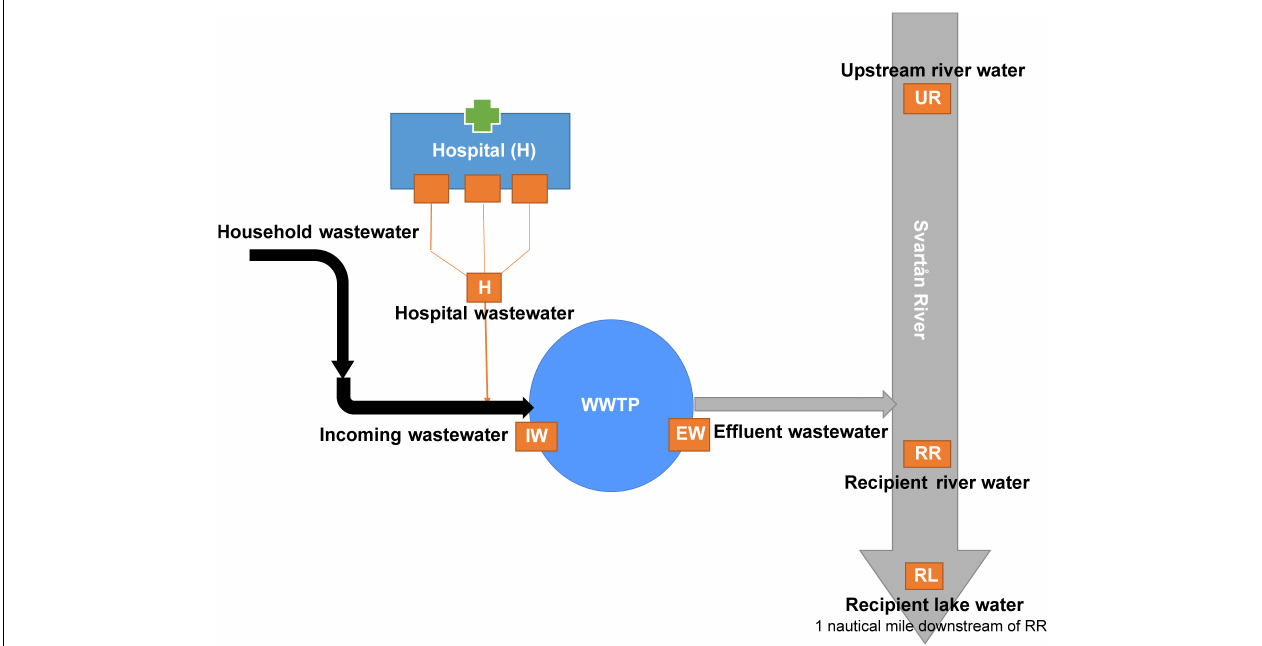
FIGURE 1 | Illustration of the sample sites along the wastewater system in Örebro city, Sweden. Wastewater from households, industries, and the hospital are transported to the wastewater treatment plant (WWTP) located along the Svartån river downstream of Örebro City. Svartån River flows through the city and exits into Hjälmaren Lake. Sample locations are indicated as orange boxes. Wastewater samples were collected from hospital effluent (H), and incoming wastewater (IW), and treated effluent wastewater (EW) at the WWTP. Environmental water samples were collected from Svartån River upstream of Örebro city (UR), Svartån River downstream of WWTP (RR) and Hjälmaren Lake (RL), which is one nautical mile downstream of